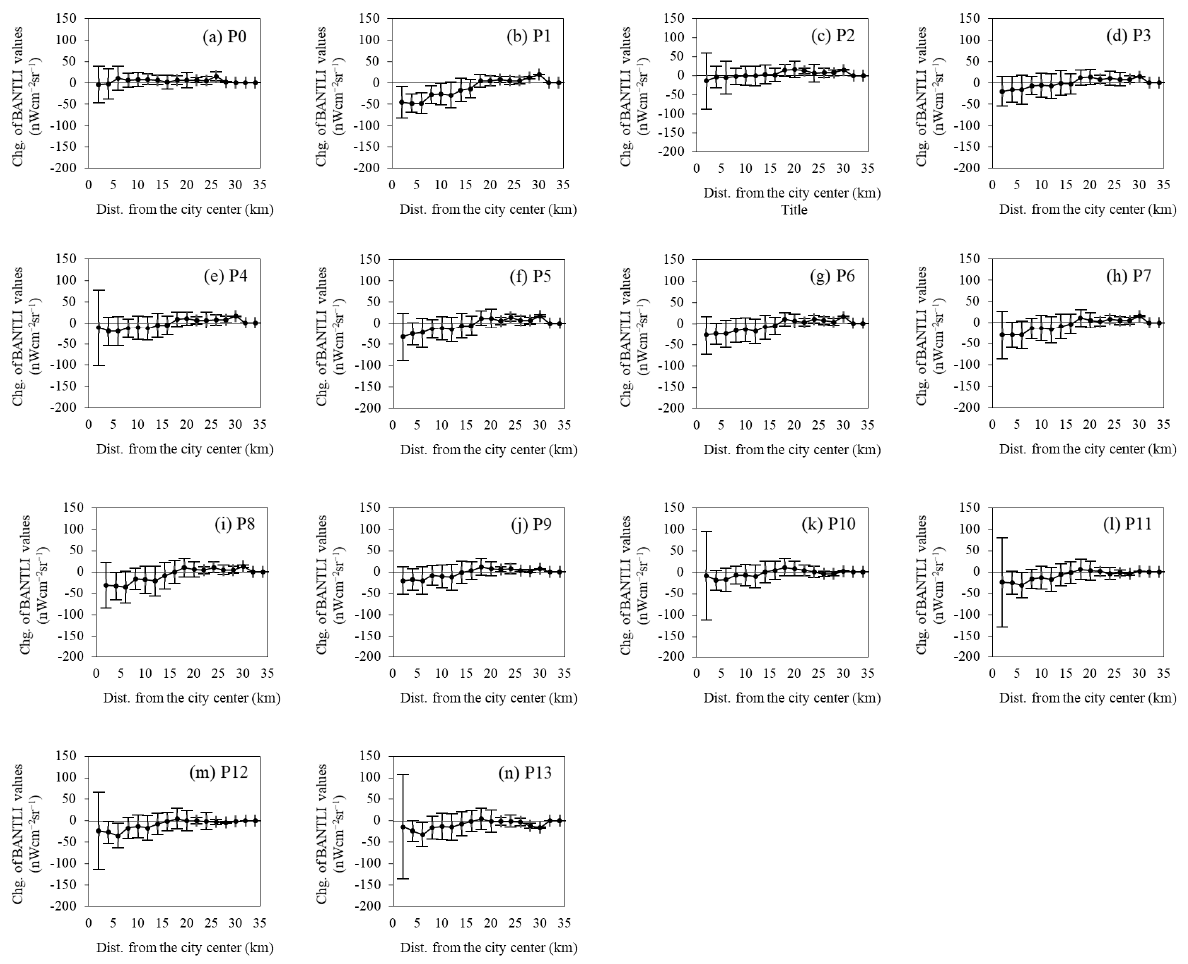
Figure 14. The mean (black line) and STD (error bar) of BANTLI brightness differences for the periods in concentric rings from Madinah center.